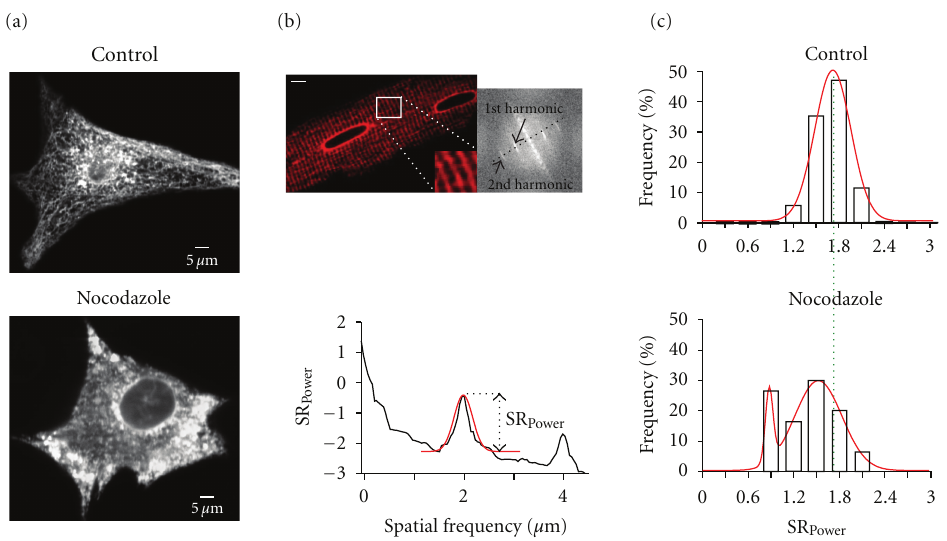
Figure 7: Microtubules regulate SR structure in neonatal and adult ventricular myocytes. (a) Confocal images of a neonatal ventricular myocyte expressing tRFP-SR in the absence (top; control) or presence of 10 μ M nocodazole (bottom). (b) Confocal image of an adult ventricular myocyte expressing tRFP-SR. The inset shows a zoomed-in region of the cell delineated by the white box. The image to the left is a 2D Fourier transformation of the confocal image. (c) Histograms of SR Power values in control and nocodazole-treated adult ventricular myocytes. Dashed green line shows global shift in SR Power distributions in nocodazole-treated myocytes from the center (1.7 μ m) of control myocytes. Solid red lines represent fits to the data with single (control; center = 1.7 μ m) and dual (nocodazole; center peak 1 = 0.88 μ m, center peak 2 = 1.53 μ m) Gaussian